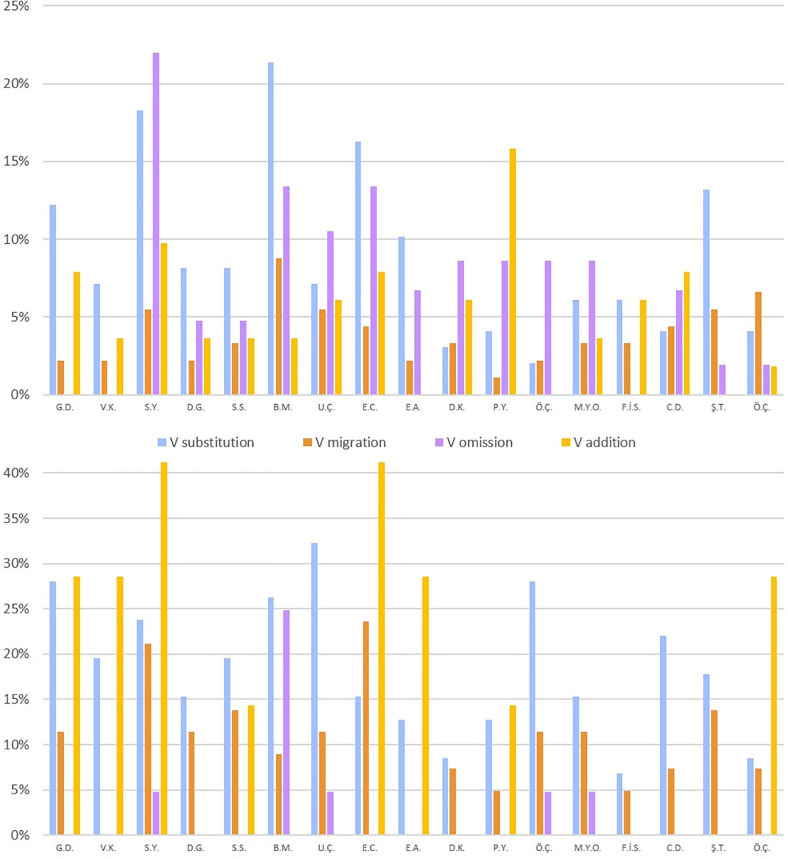
Distribution of vowel error types in words per participant out of the target words(top) and in nonwords(bottom)per participant out of the target nonwords with a lexical potential for such errors.